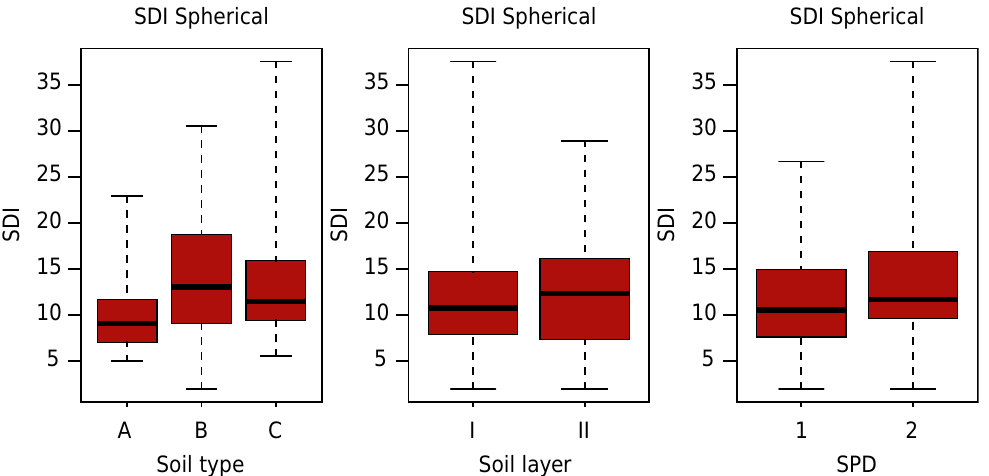
Figure 2. Boxplot graphs of the distribution of the SDI for the spherical model in different soil types, soil layers, and spatial dependencies, obtained from real data. Soil type: A = Ultisol (n = 40), B = Oxisol (n = 46), C = Others (n = 23). Soil layer: I = Surface layer (0.0-0.1, 0.0-0.15, 0.0-0.2 m) (n = 83), II = Bottom layer (0.1-0.2, 0.15-0.30, 0.2-0.3, 0.2-0.4, 0.3-0.4, 0.4-0.6 m) (n = 23). SPD: 1 = 0 ≤ SPD ≤ 75 % (n=80), 2 = SPD > 75 % (n =